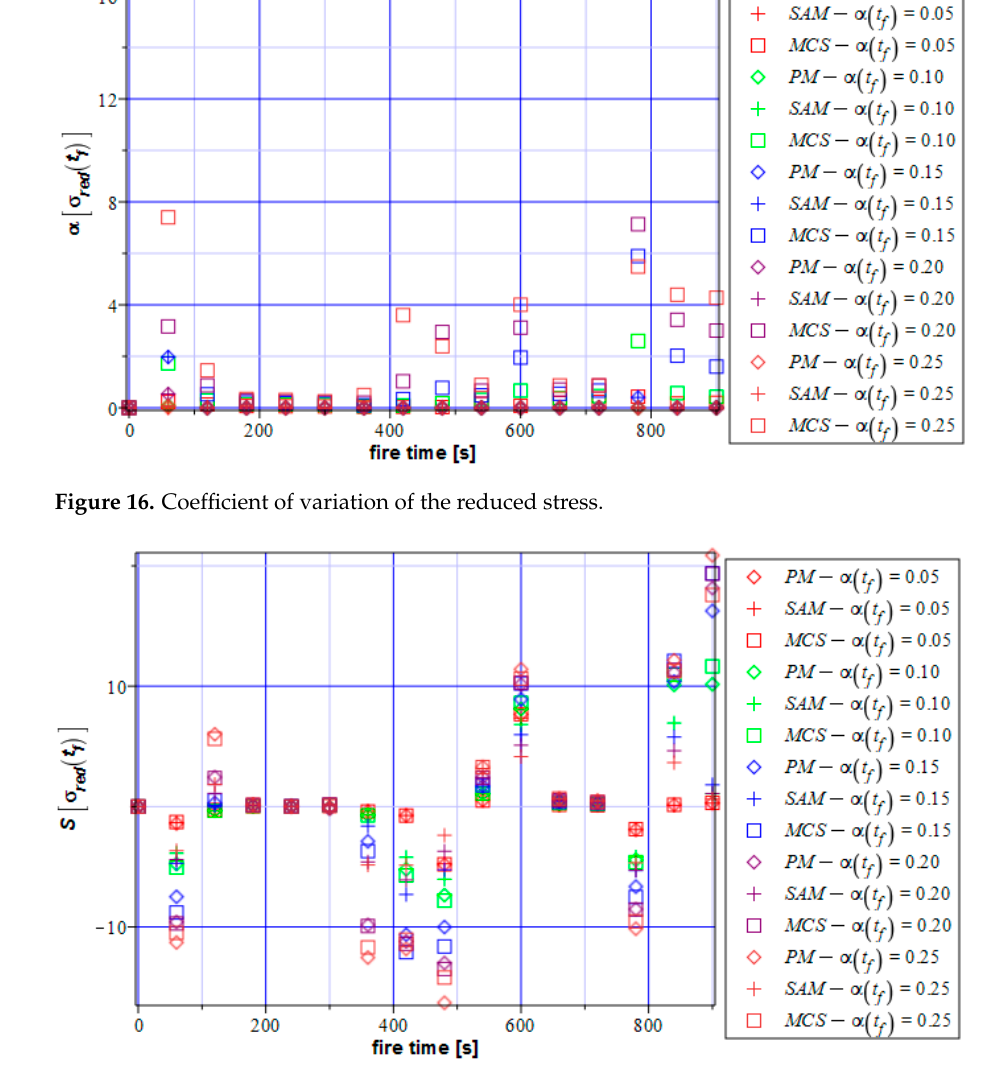
Figure 17. The skewness of the reduced stress.